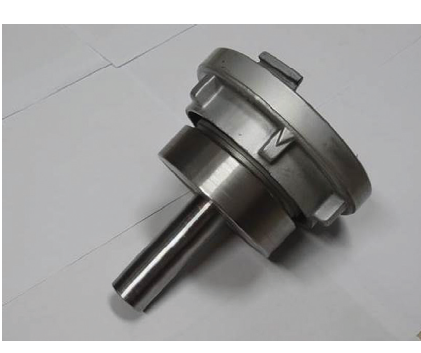
Figure 29: Auxiliary fixture assembly.